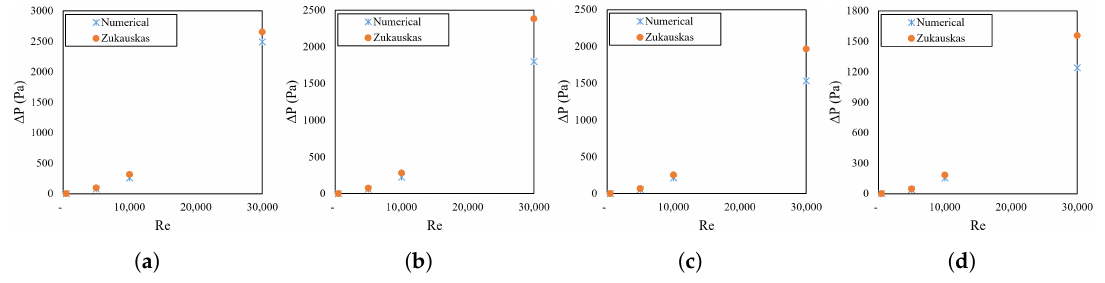
Figure 7. Pressure drop validation. ( a ) 1.3 Pitch Ratio; ( b ) 1.6 Pitch Ratio; ( c ) 2.0 Pitch Ratio; ( d ) 3.0 Pitch